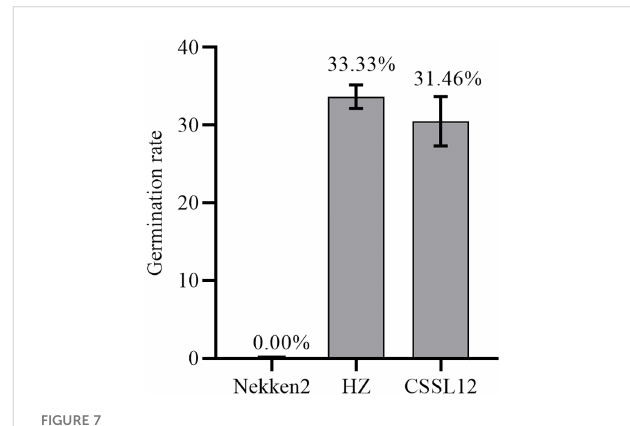
FIGURE 7 The germination rate for Nekken2, HZ and CSSL12.